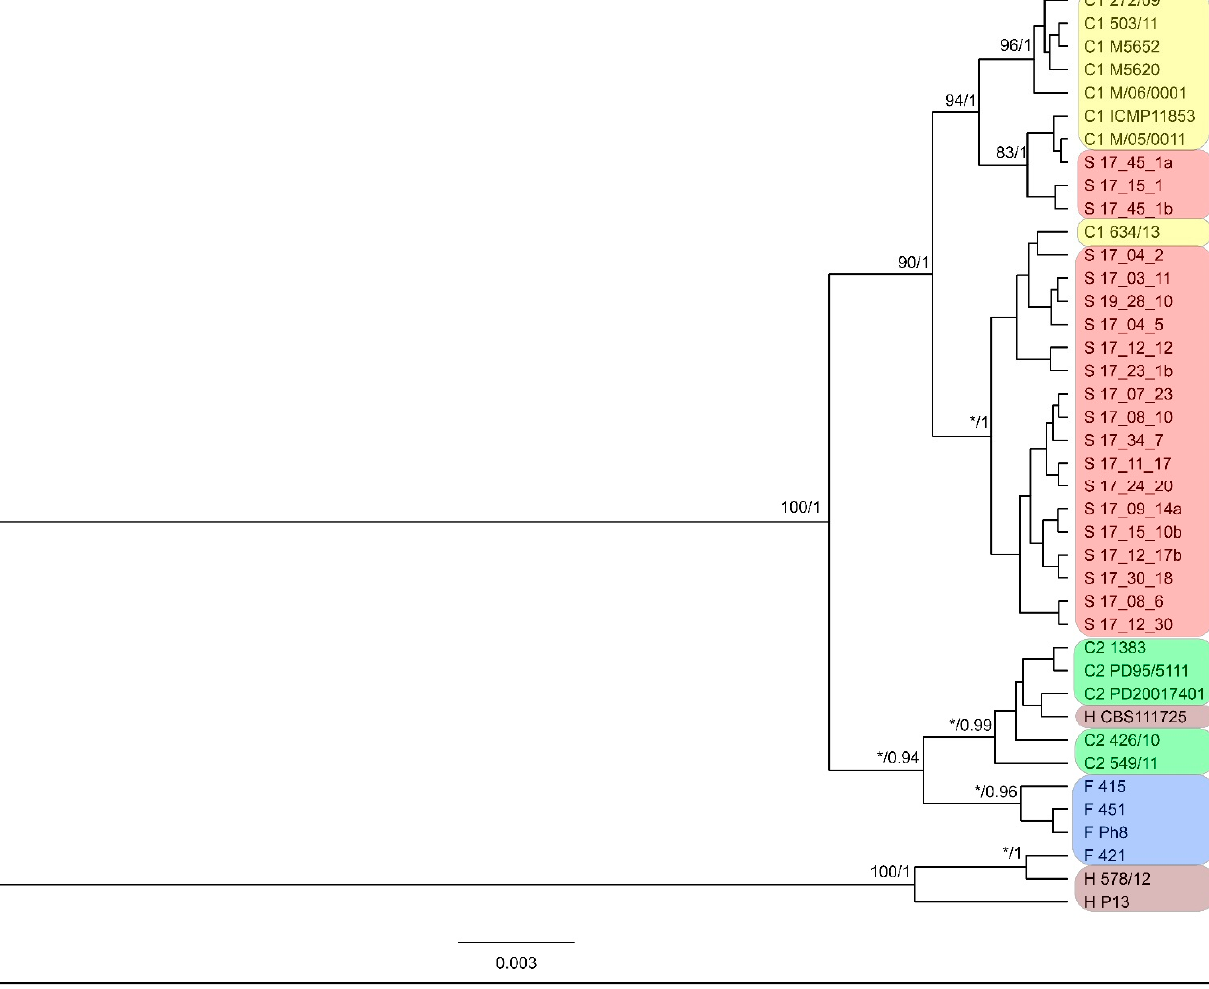
Figure 2. Phylogenetic tree based on three concatenated effector gene loci, RXLR6, RXLR7 and SCR113. The tips of branches are labelled by isolate ID and by the grouping the isolates in genetic groups according to structure analysis results. Numbers at branches indicate maximum likelihood bootstrap proportion and Bayesian posterior probability values. The asterisks (*) mark low support (<75 in maximum likelihood; <90 in Bayesian analysis). The bar indicates the number of expected substitutions per